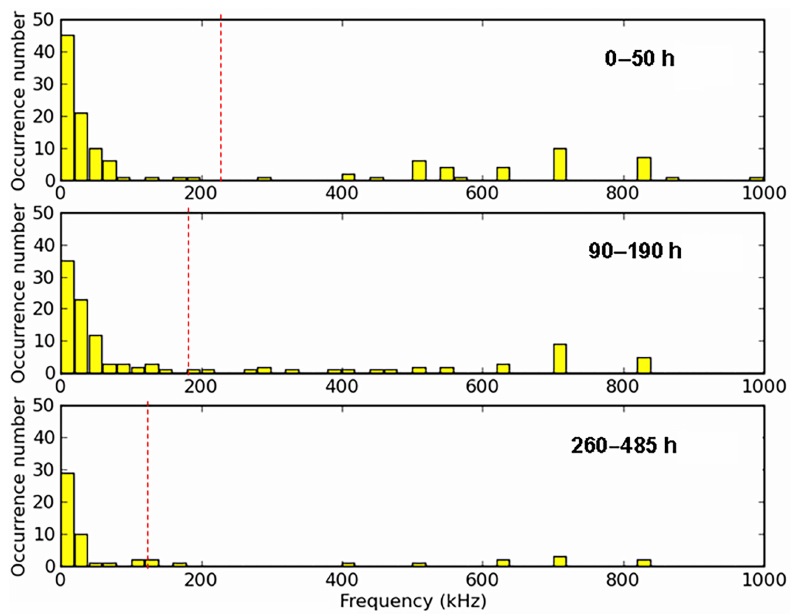
Figure 7. Histograms representing successive statistical distribution of the AE signal frequencies with bins 20kHz wide starting at 10kHz. The dashed lines represent the mean value of each distribution: 221, 193 and 141kHz (top to bottom).